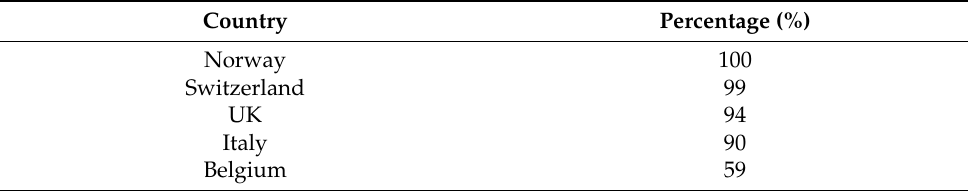
Table 3. Cars with DAB+ radio compatibility.